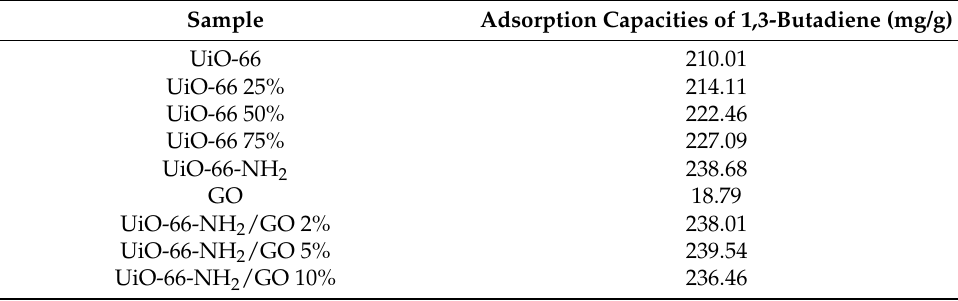
Figure 7. ( a ) Adsorption isotherm of UiO-66 X% on pure 1,3-butadiene. ( b ) Adsorption isotherm of UiO-66-NH 2 /GO Y% on pure 1,3-butadiene. Table 6. Adsorption capacities of pure 1,3-butadiene on the adsorbent